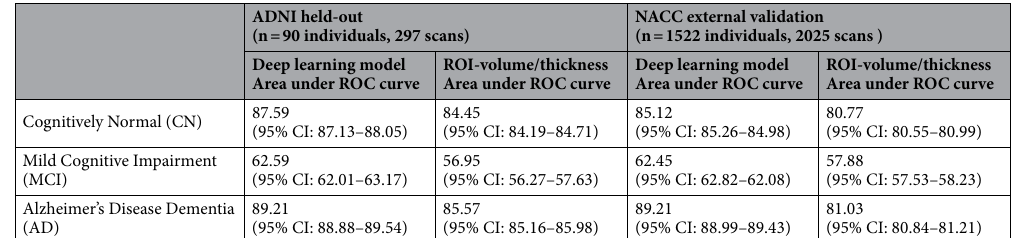
ADNI held-out (n = 90 individuals, 297